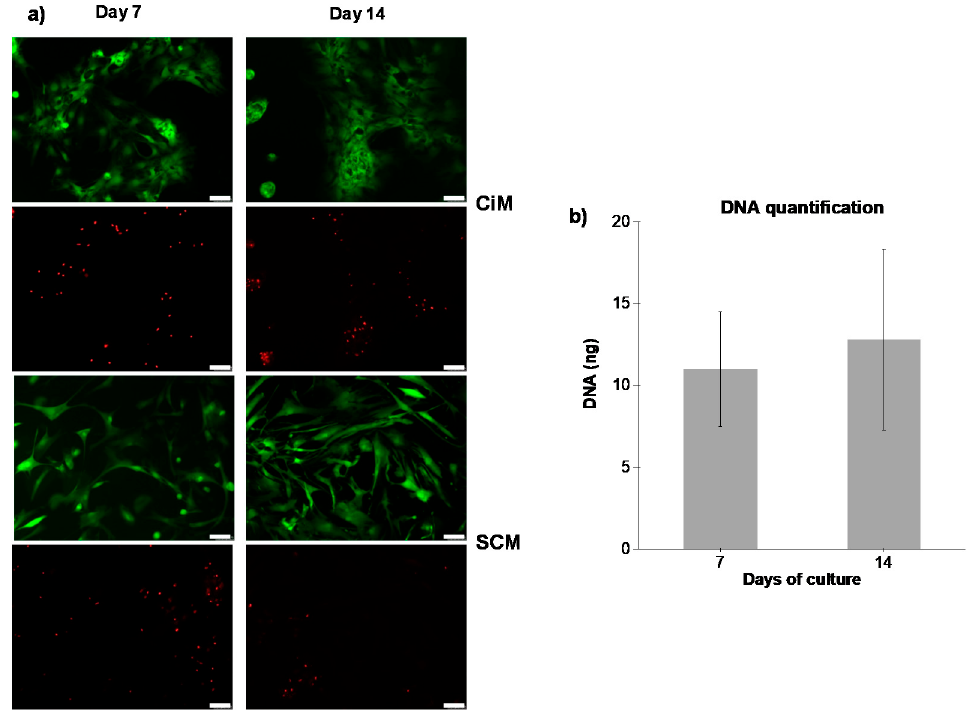
Figure 5. ( a ) Live / dead staining of human mesenchymal stem cells (hMSCs) encapsulated in MeHA hydrogels (5 w / v%) and cultured in chondrogenic medium (CiM) or stem cell medium (SCM) after 7 and 14 days of culture. Scale bar = 75 µ m. ( b ) DNA amount of hMSC-laden MeHA hydrogels cultured in SCM for 7 and 14 days.